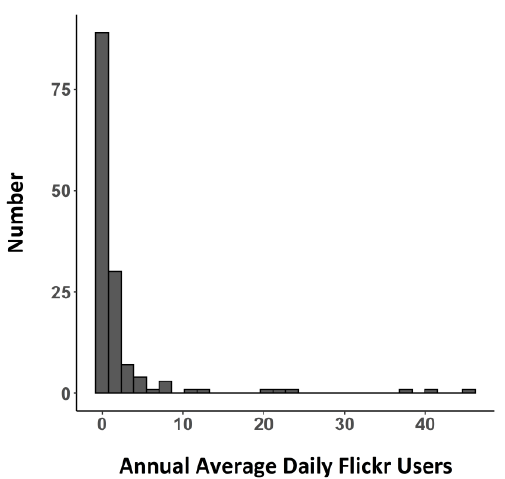
Figure A3. Histogram of the annual average daily Flickr users.